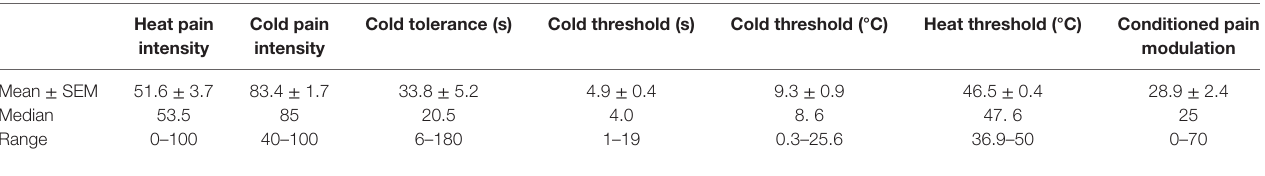
Table 1 | Descriptive values of pain parameters examined before the study